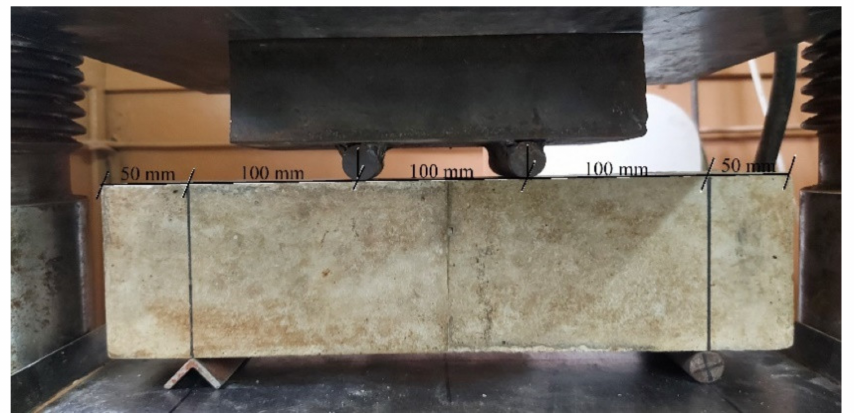
Figure 2. Flexural strength test using a 4-point load